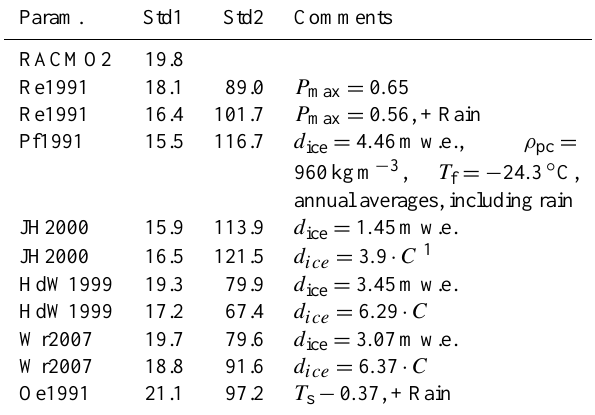
Table 4. Statistics of the different parameterizations compared to RACMO2 after tuning. Headings are as in Table 2, comments refers to changes in parameter setting compared to the refer- ence (Table 2). In all experiments Mean=112.9mmw.e.yr − 1 and Diff=0.0mmw.e.yr − 1